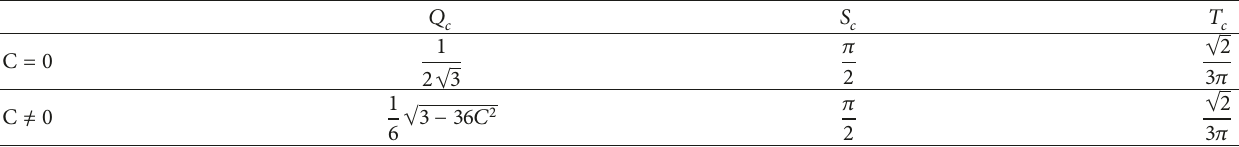
Table 1: Coordinates of the critical points for different values of 𝐶 in (𝑇,𝑆) -diagram.